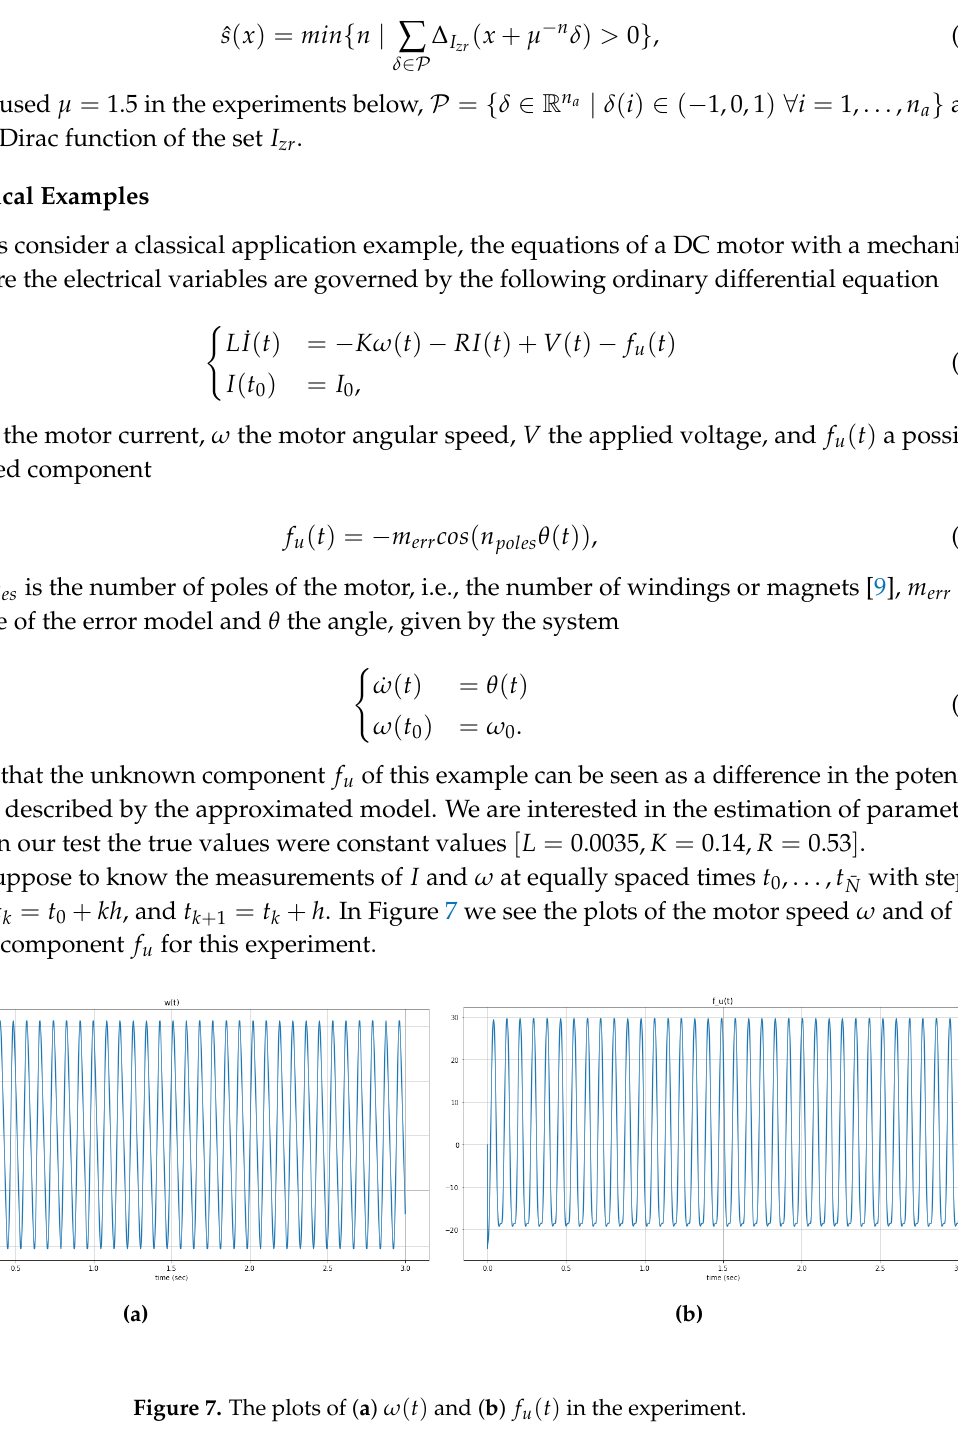
Figure 7. The plots of ( a ) ω ( t ) and ( b ) f u ( t ) in the